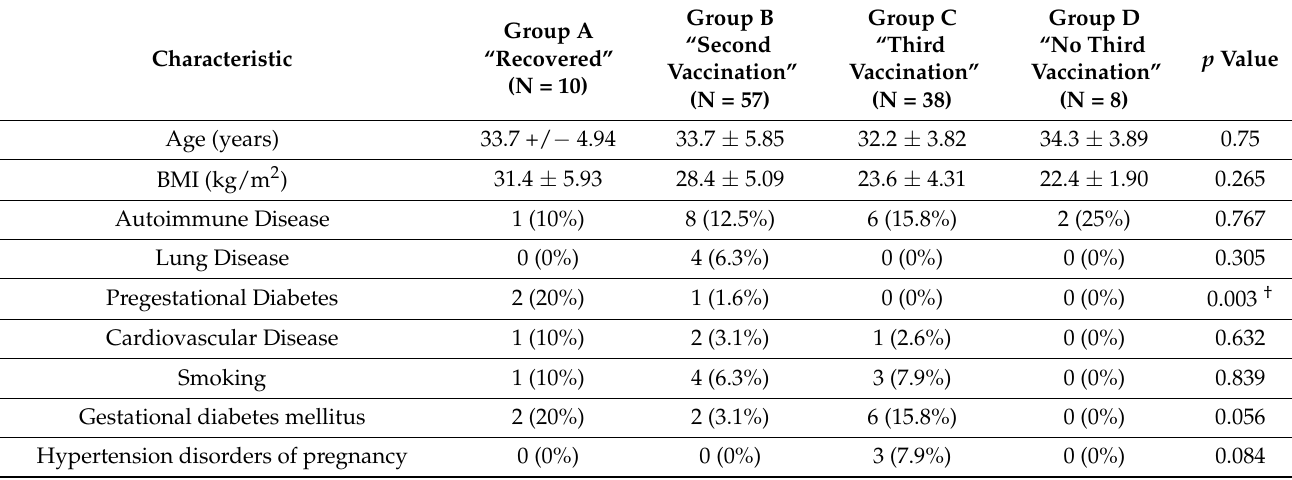
Table 1. Baseline maternal and obstetric characteristics.